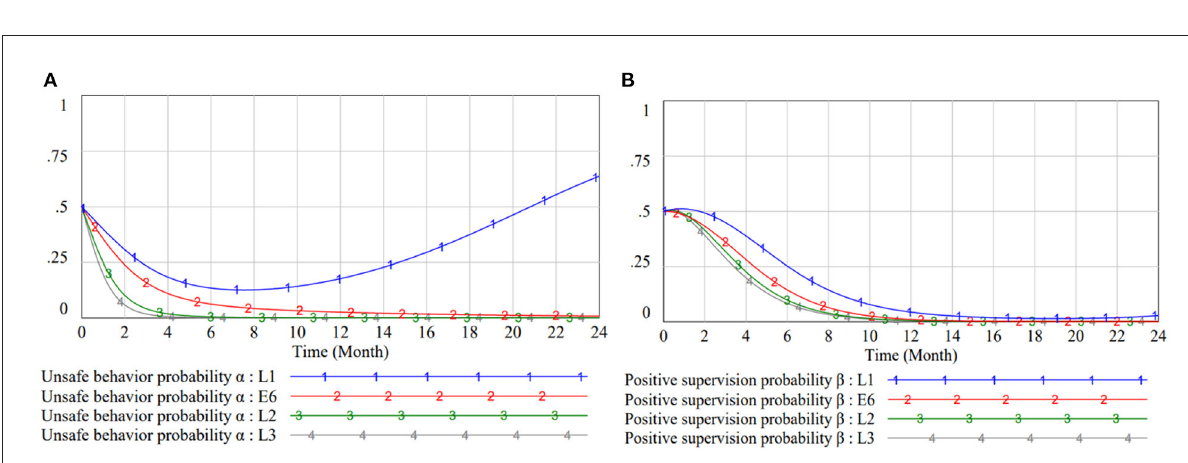
FIGURE8 Impact of risk loss on subject strategies. (A) Impact of risk loss on workers strategy selection in different scenarios. (B) Impact of risk loss on managers strategy selection in different